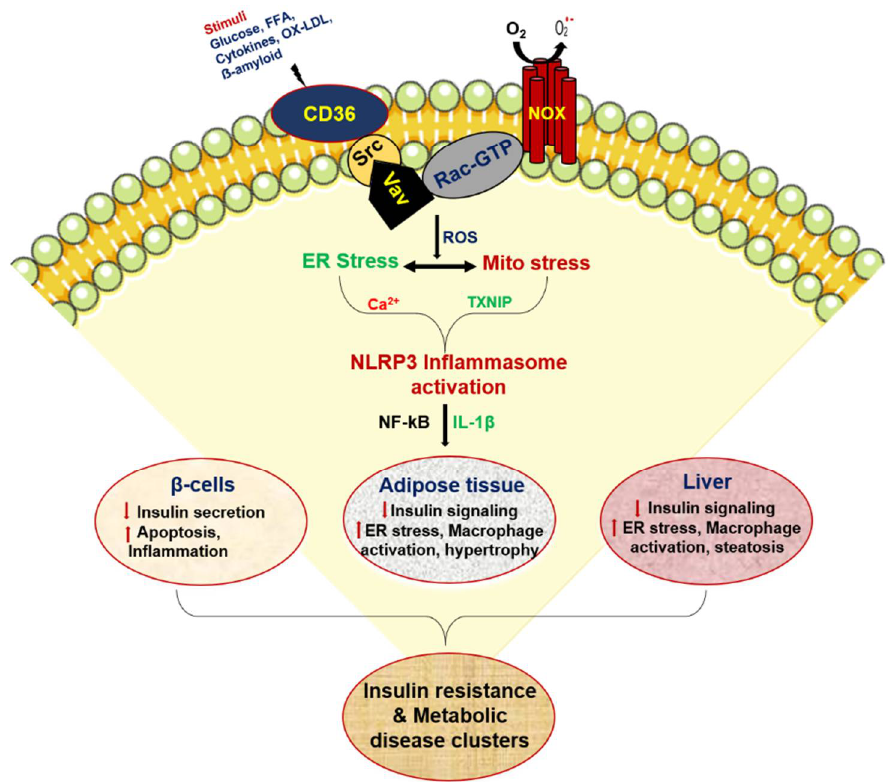
Figure 3. CD36 redox signaling mediates peripheral insulin resistance during metabolic disease.